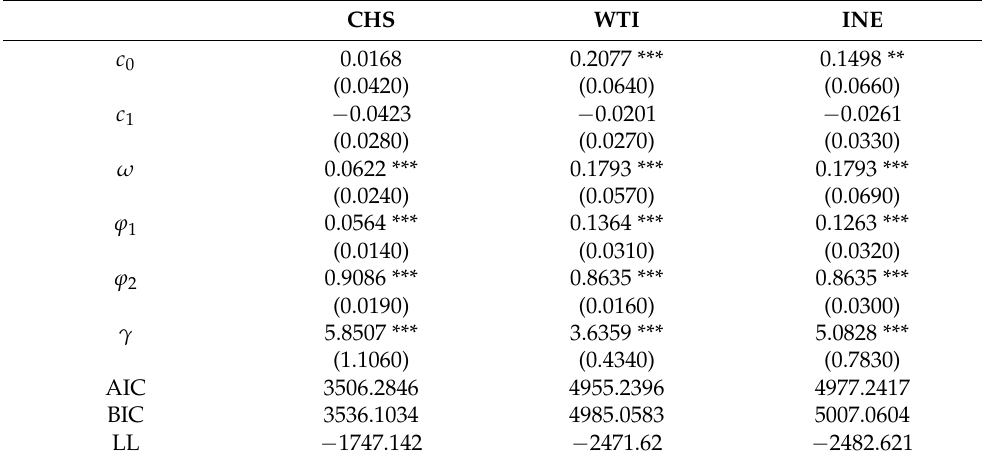
Table 3. Estimate results of marginal distribution based on the AR (1)-GARCH (1,1) model (total sample). CHS WTI